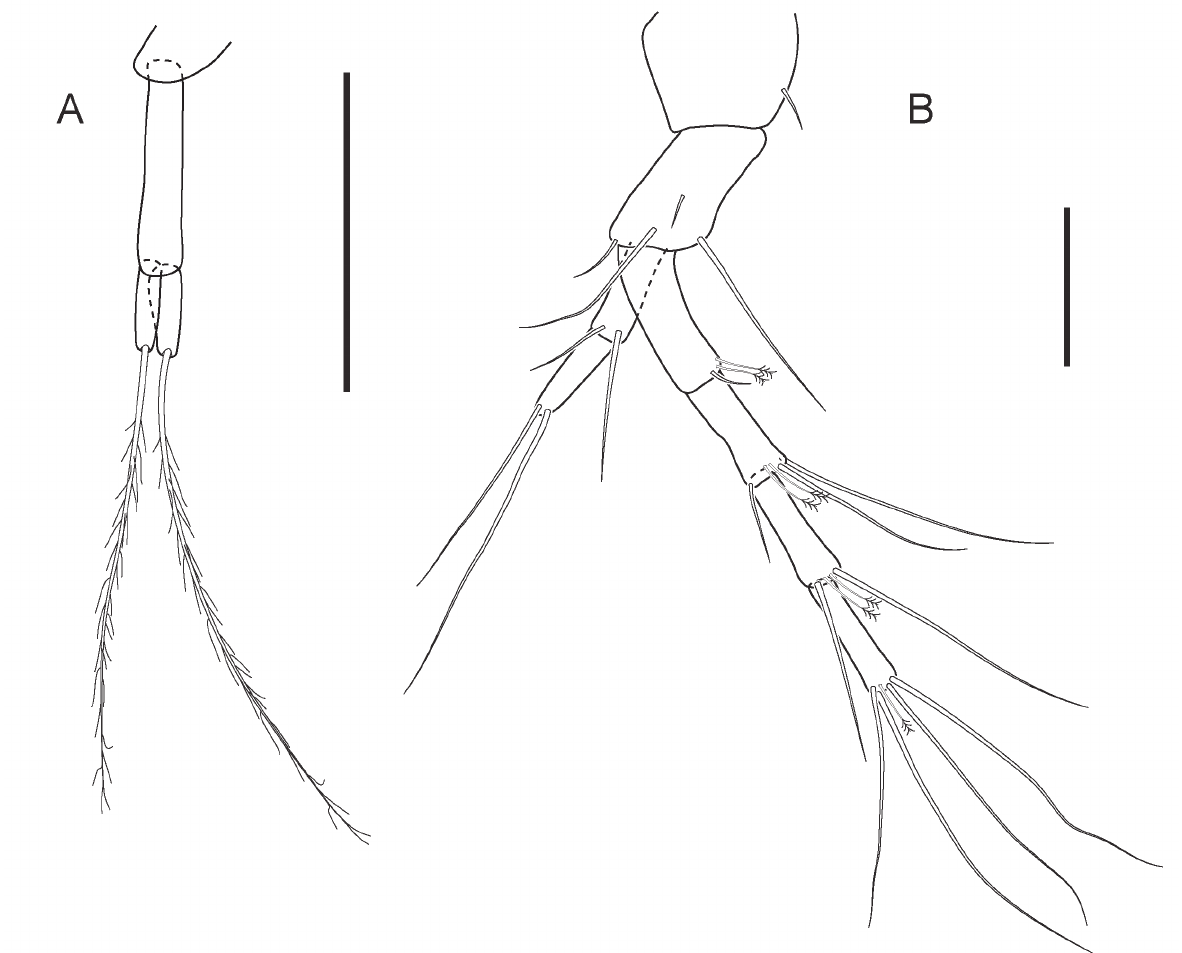
Figure 7. Apseudomorpha brasiliensis sp. nov. Paratype, ovigerous female dissected (MNRJ 29857). A Pleopod; B uropod. Scale bars: 0.1